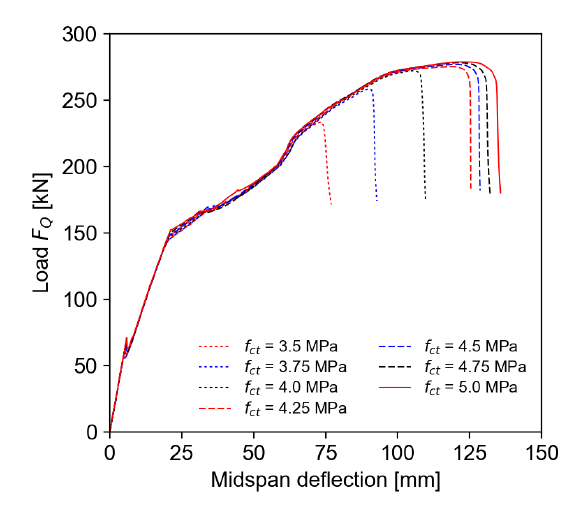
Figure 5. Influence of the concrete tensile strength f ct on the load-displacement behaviour of restrained hollow core